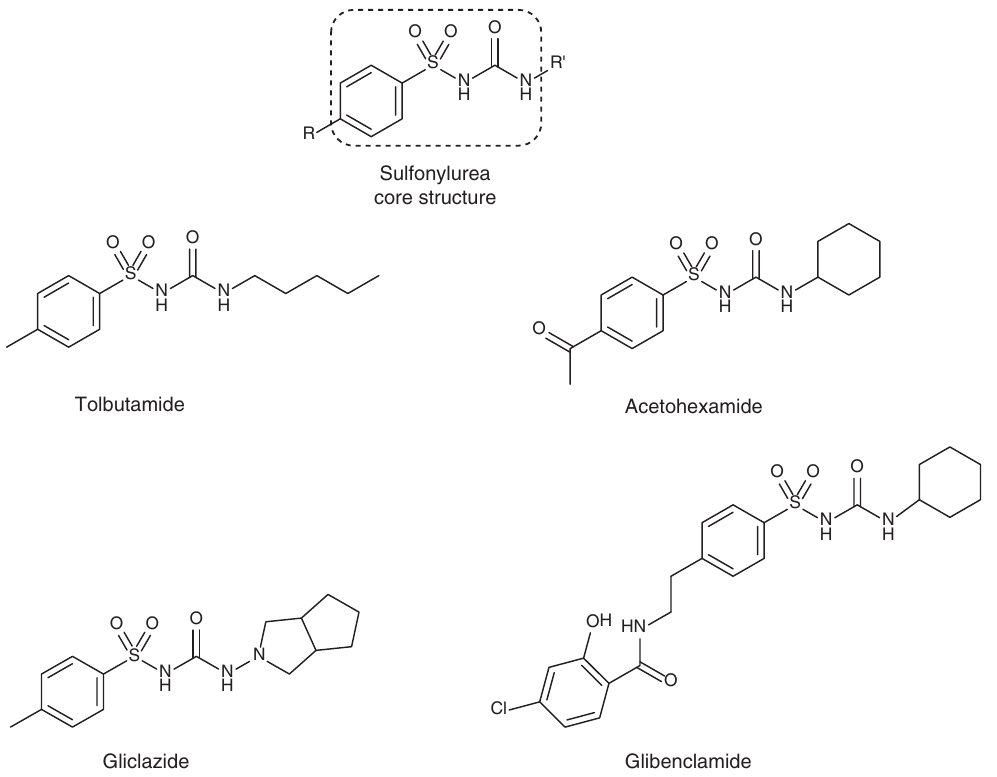
Figure 1 Core structure of a sulfonylurea drug and examples of first-generation sulfonylurea drugs (e.g., tolbutamide and acetohexamide) or second-generation sulfonylurea drugs (e.g., gliclazide and